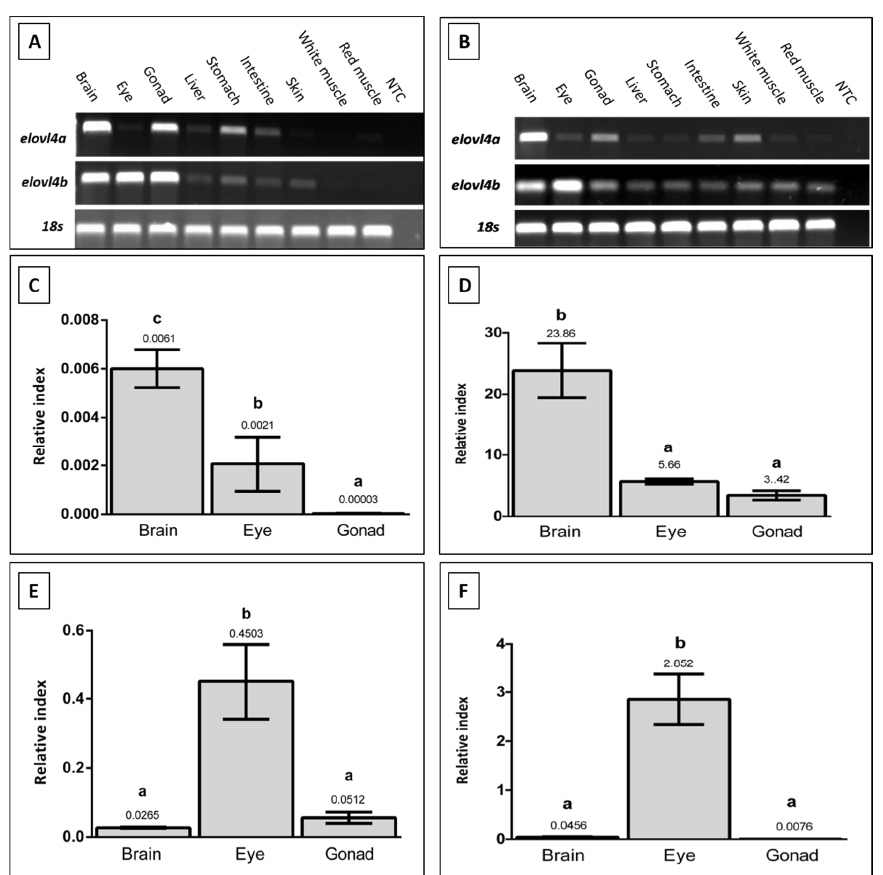
Figure 3. Tissue distribution of elovl4a and elovl4b transcripts in Sparus aurata ( A ) and Solea senegalensis ( B ) determined by Reverse Transcriptase-Polymerase Chain Reaction (RT-PCR) ( n = 1 fish). Expression of housekeeping gene 18s is also shown. Expression in selected tissues of Sparus aurata elovl4a ( C ) Solea senegalensis elovl4a ( D ), Sparus aurata elovl4b ( E ) and Solea senegalensis elovl4b ( F ) transcripts were also determined by qPCR. The results, shown as relative index, are β -actin normalized values (gene copy number/ β -actin copy number). Bars represent means and standard deviations ( n = 3 fish). Different letters denote significant differences (ANOVA and Tukey HSD test, p ≤ 0.05) among tissues.